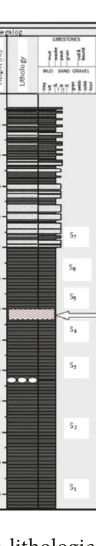
Figure 5: A composite lithologic log of the section of the Djega outcrop under study showing the position of the K/Pg,